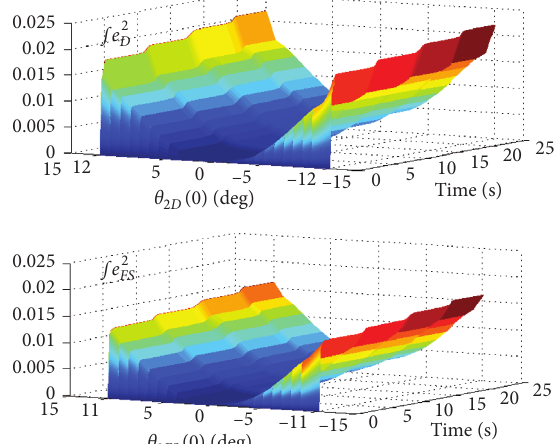
Figure 22: Power spectrum density.